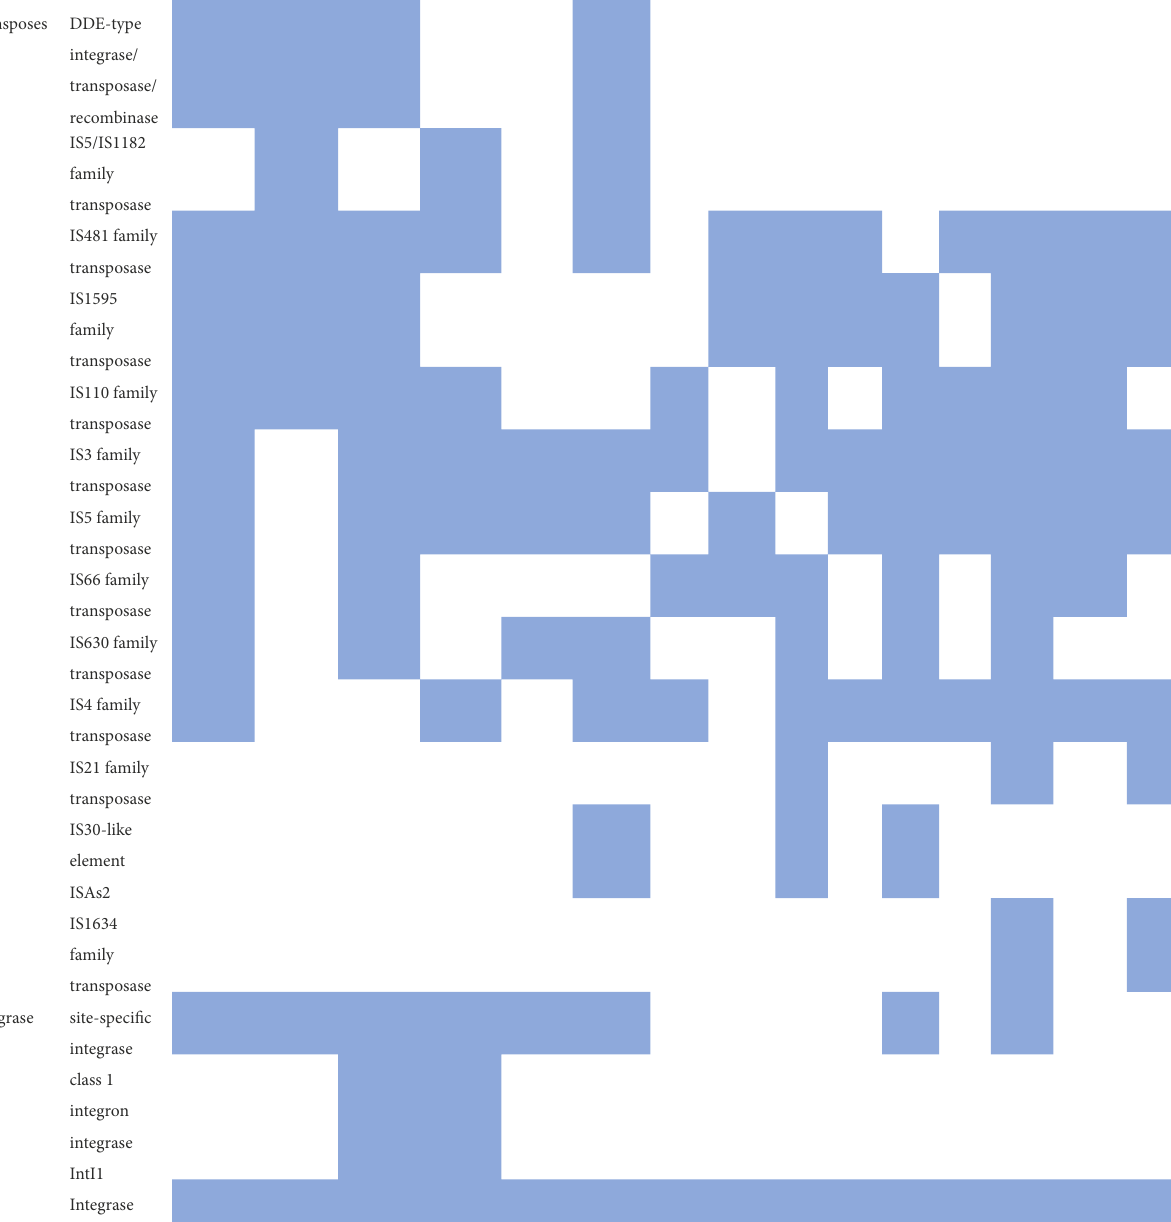
TABLE 6 Transposases and integrases detected from the Aeromonas genomes. Transposes/ Integrases gene